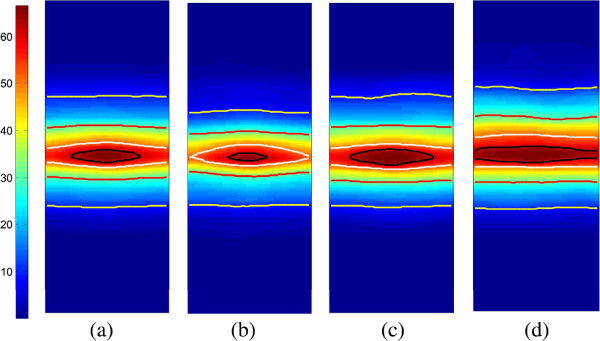
The average dose map of the locally registered ESDMs. (a) all patients; (b) patients with AET Grade 0–1; (c) patients with AET Grade 2; (d) patients with AET Grade 3. The iso-dose lines of 60 Gy, 50 Gy, 30 Gy and 10 Gy are marked in black, white, red and yellow.